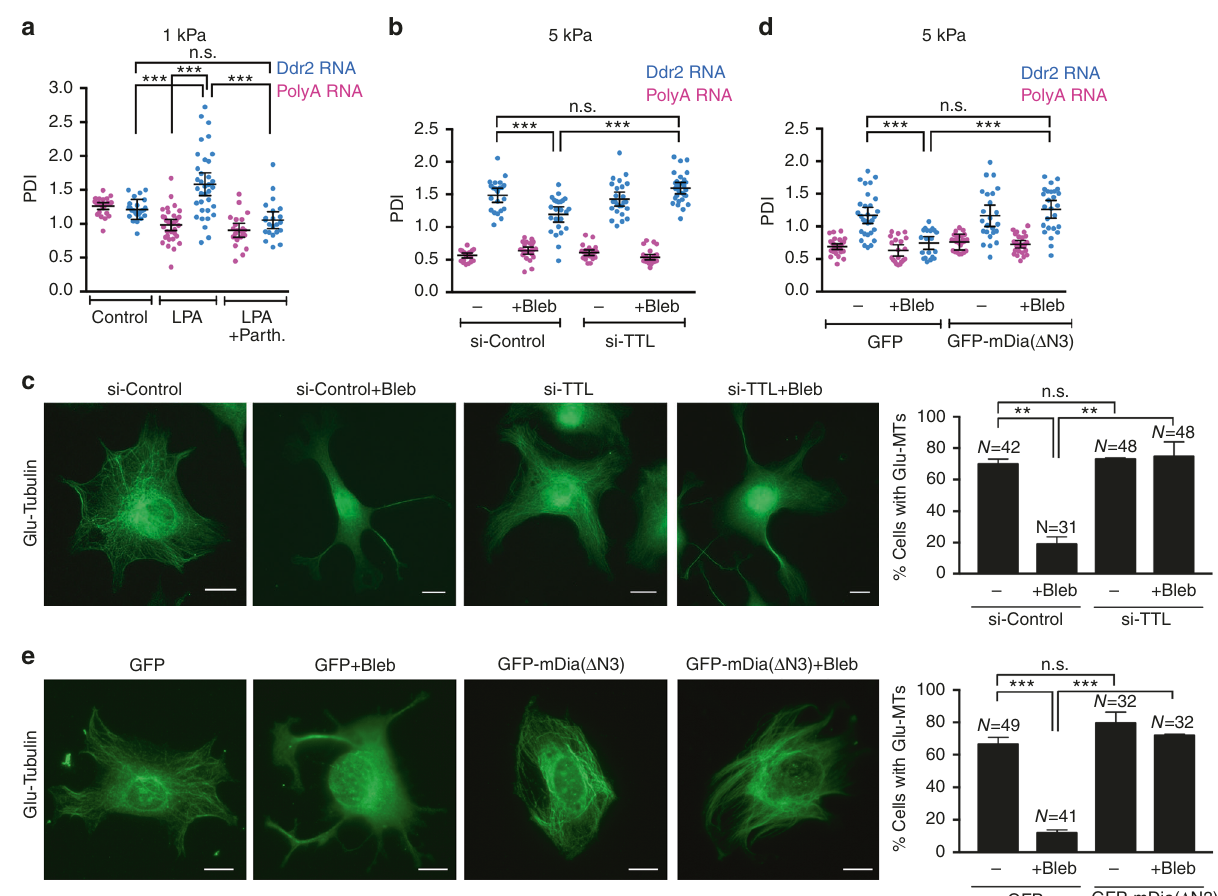
Fig. 6 Detyrosinated microtubules mediate the effect of contractility on APC-dependent RNA localization at protrusions. a FISH analysis of cells on 1 kPa substrates treated with LPA alone or LPA together with parthenolide. PDI values of Ddr2 and polyA RNA are shown. b FISH analysis of control or TTL knockdown cells, treated or not with blebbistatin as indicated. Cells were plated on 5 kPa substrates. PDI values of Ddr2 and polyA RNA are shown. c Representative Glu-tubulin immuno fl uorescence staining of cells treated as in b . Graph shows corresponding percentages of cells exhibiting a Glu-MT network. d FISH analysis of cells transfected with GFP or GFP-mDia( Δ N3), treated or not with blebbistatin as indicated. Cells were plated on 5 kPa substrates. PDI values of Ddr2 and polyA RNA are shown. e Representative Glu-tubulin immuno fl uorescence staining of cells treated as in d . Graph shows corresponding percentages of cells exhibiting a Glu-MT network. For all PDI quanti fi cations, bars represent the mean with 95% con fi dence interval. Points indicate individual cells analyzed in at least two or more independent experiments. For cell percentages, error bars show standard error and N is the total number of cells observed in two or more biological replicates. p -values: *** < 0.001, ** < 0.01 by analysis of variance with Bonferroni ’ s multiple